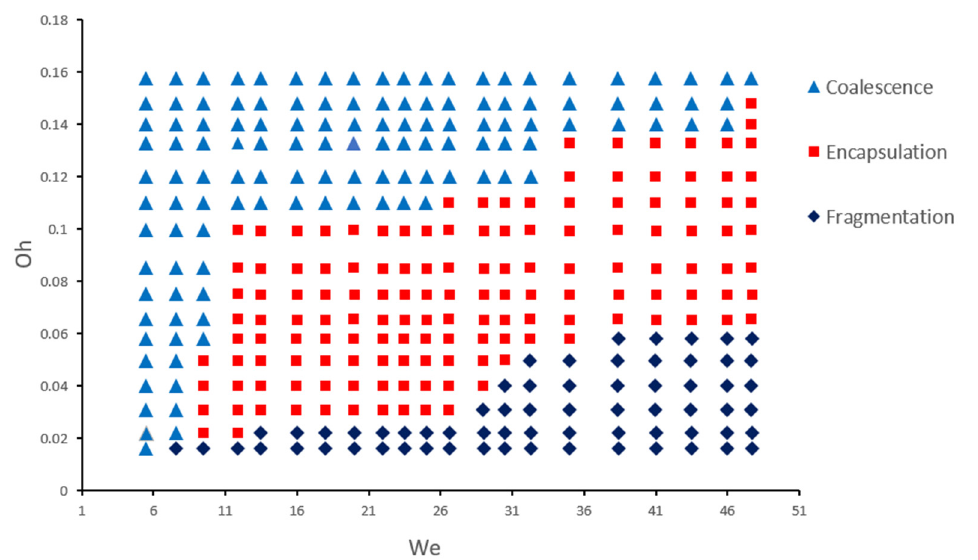
Figure 12. Phase diagram of collision regimes of equal-sized immiscible droplets characterized by the Weber and Ohnesorge numbers. the Weber and Ohnesorge